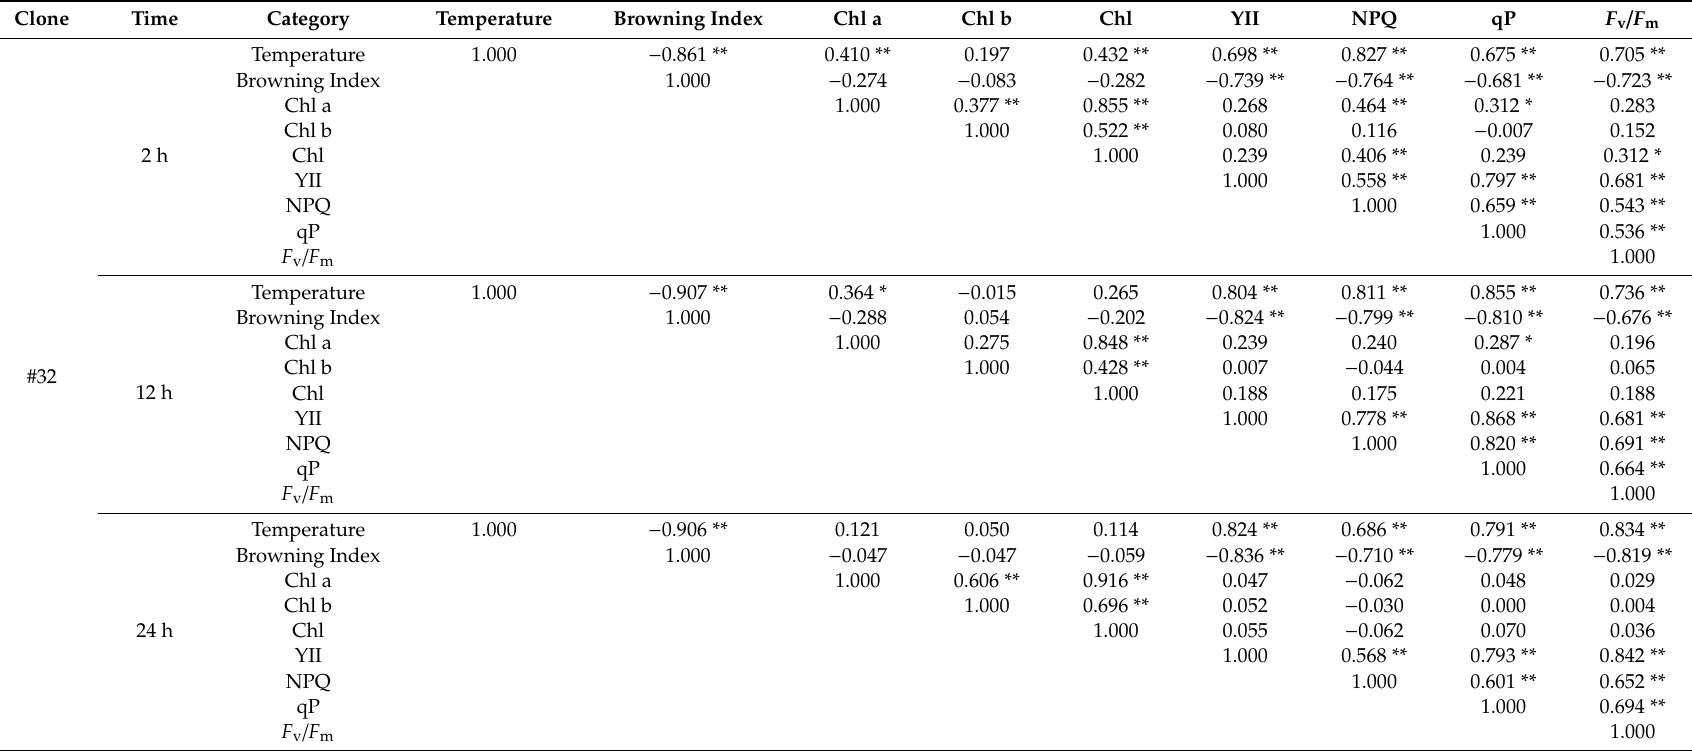
Table A1. Correlation analysis of physiological indexes of C. fortunei under LT (from 25 to − 20 ◦